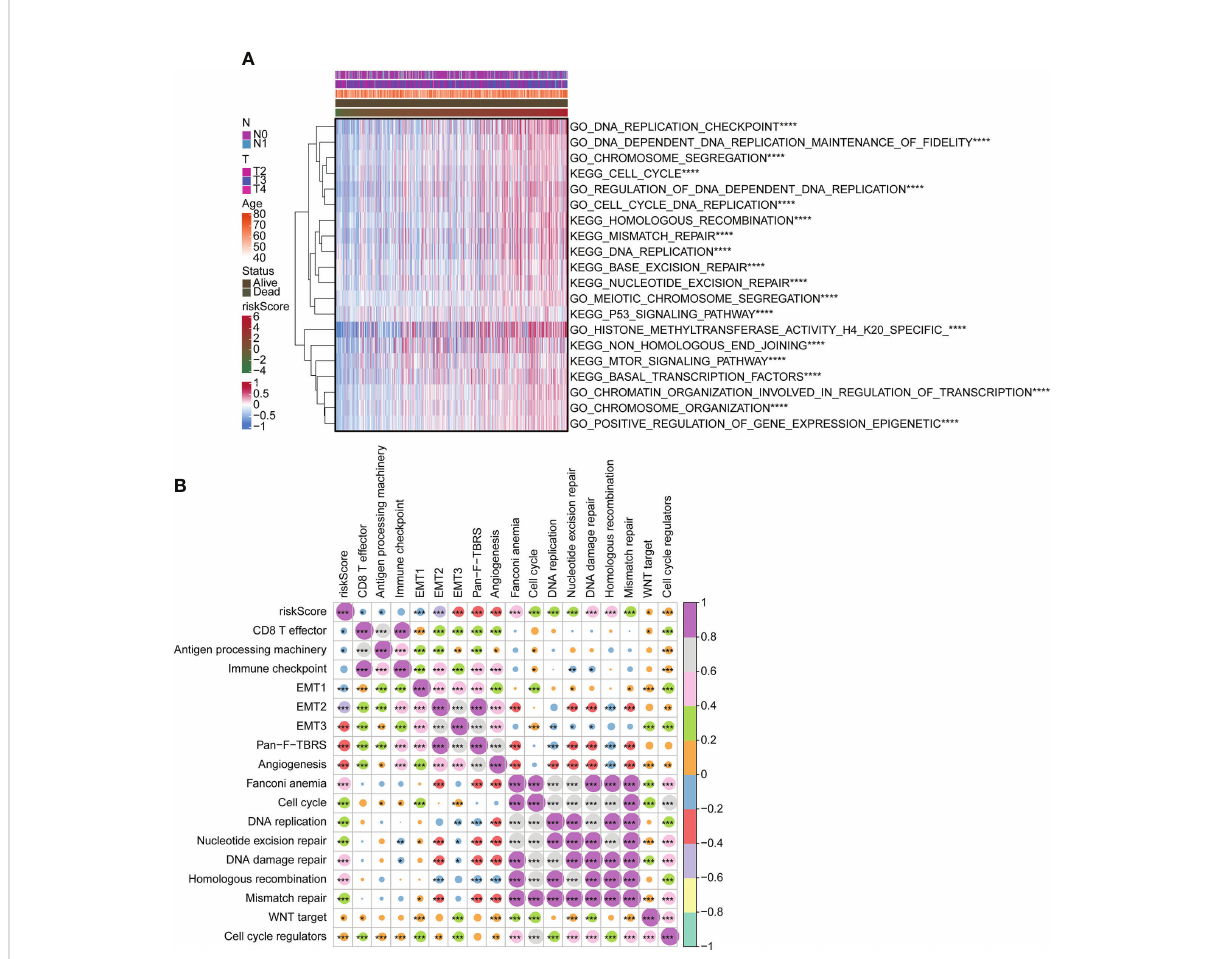
FIGURE 4 Functional analysis of risk score. (A) Heatmap for GO and KEGG analyses using GSVA package. (B) Correlation of risk score with functional enrichment pathways. GO, Gene Ontology; KEGG, Kyoto Encyclopedia of Genes and Genomes; GSVA, gene set variation analysis. *p < 0.05. **p < 0.01. ***p < 0.001 ****p <